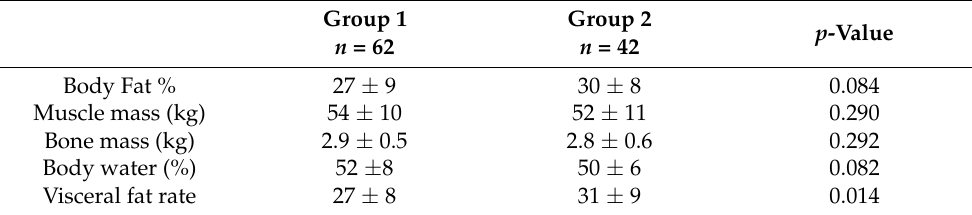
Table 3. Body Composition